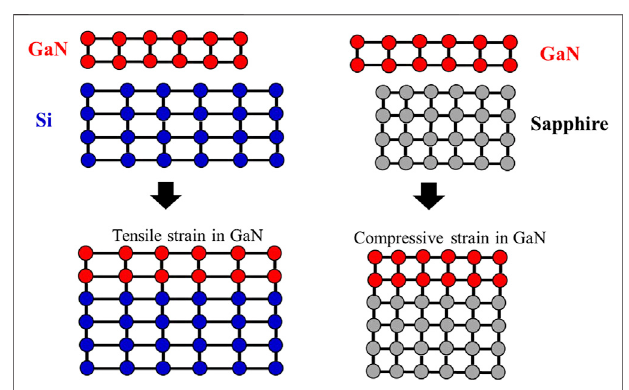
FIGURE2| TheschematicofthelatticedifferenceandthestrainforGaN fi lms grown on Si (left) and sapphire (right).